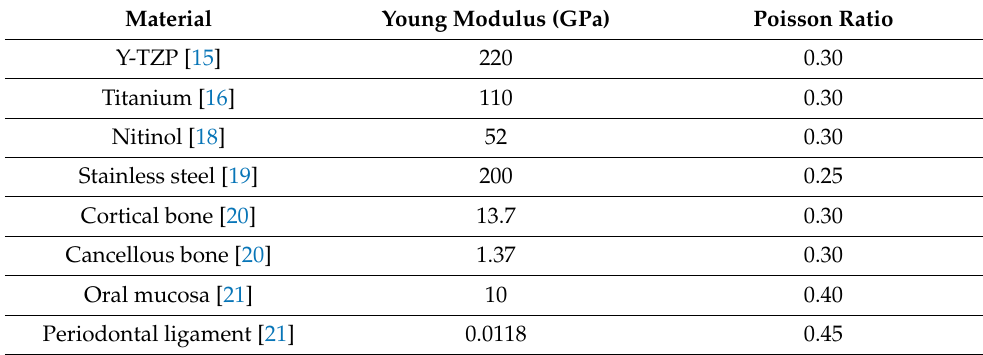
Table 1. Material properties used in the present numerical analysis.